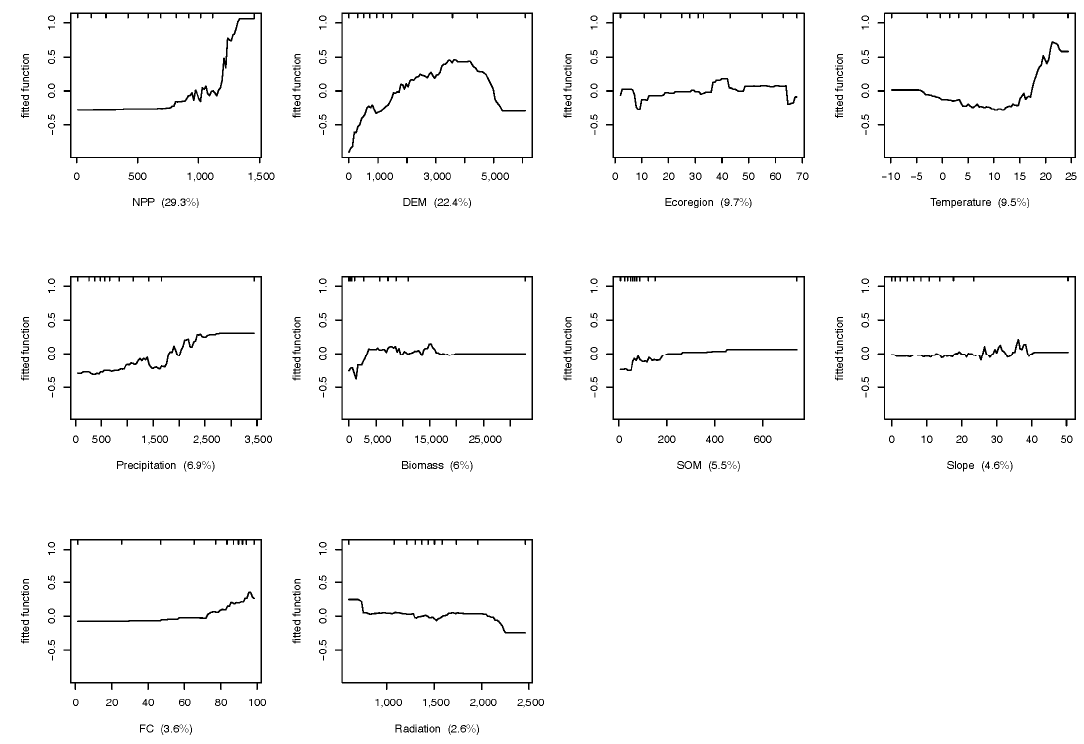
Figure 3. Contribution of impact factors on the distribution of species richness at the coarse scale.